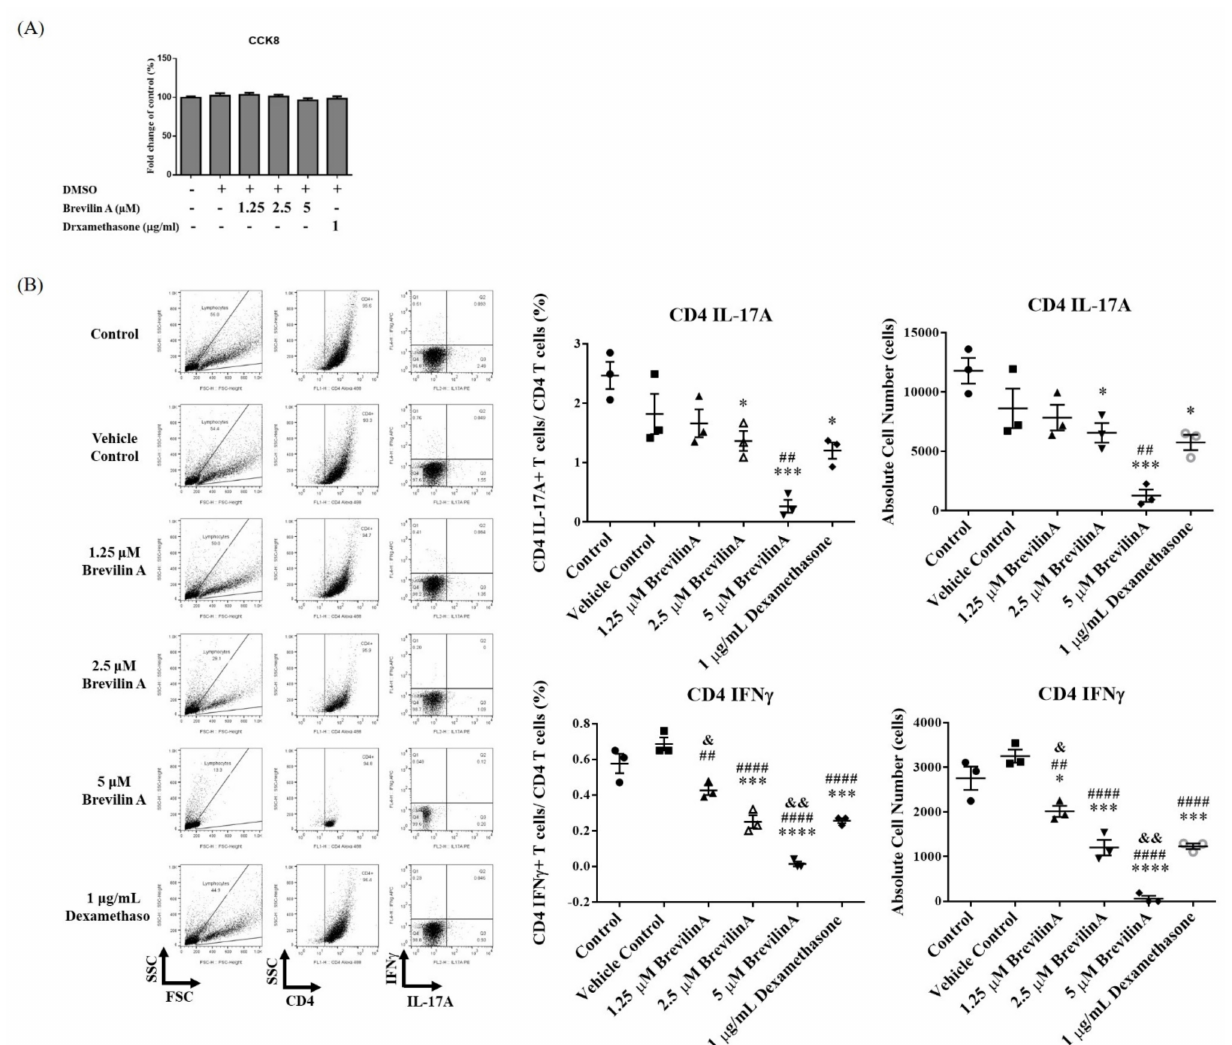
Figure 3. Brevilin A inhibited naïve CD4+ T cells from differentiating into Th17 cells. Naïve CD4+ T cells were isolated from the spleen and lymph nodes of C57BL/6 mice and stimulated with Th17, skewing condition and different doses of brevilin A for 4 days. Dexamethasone was used as the treatment control. ( A ) Cell viability was measured by CCK − 8. ( B ) Expressions of CD4, IFN − γ , and IL − 17A were detected by flow cytometer; the results are expressed as the mean ± SEM. * p < 0.05, *** p < 0.005, **** p < 0.001 vs. control group. ## p < 0.01, #### p < 0.001 vs. DMSO